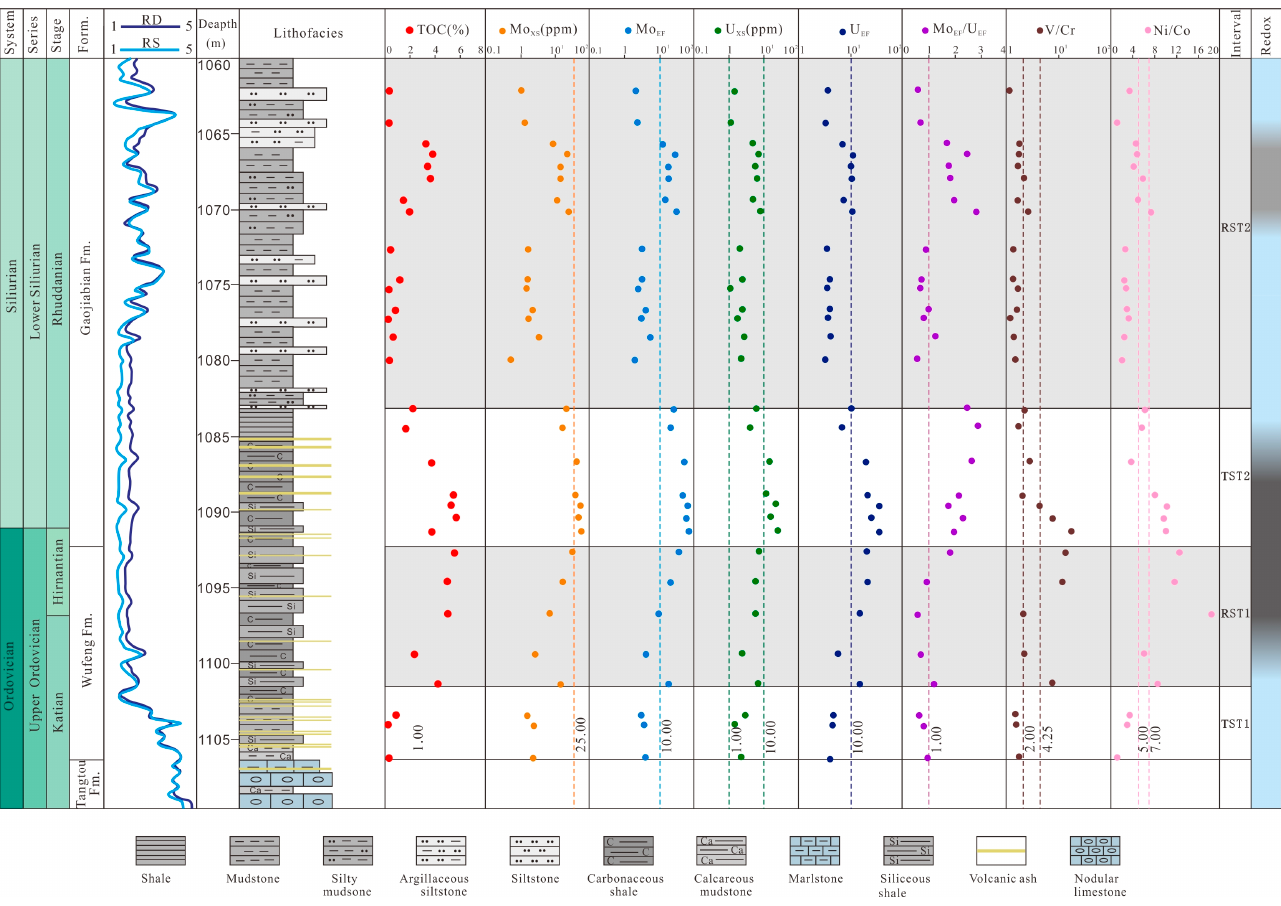
Figure 4. Vertical variations of TOC and redox proxies in Well SY1. Vertical dashed lines in each column mark key threshold values of redox-sensitive trace element proxies.